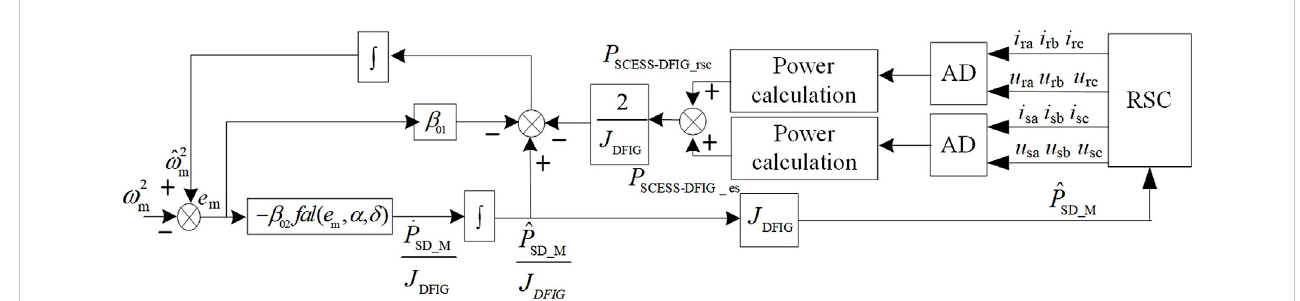
FIGURE 6 The working principle of the ESO for the mechanical power